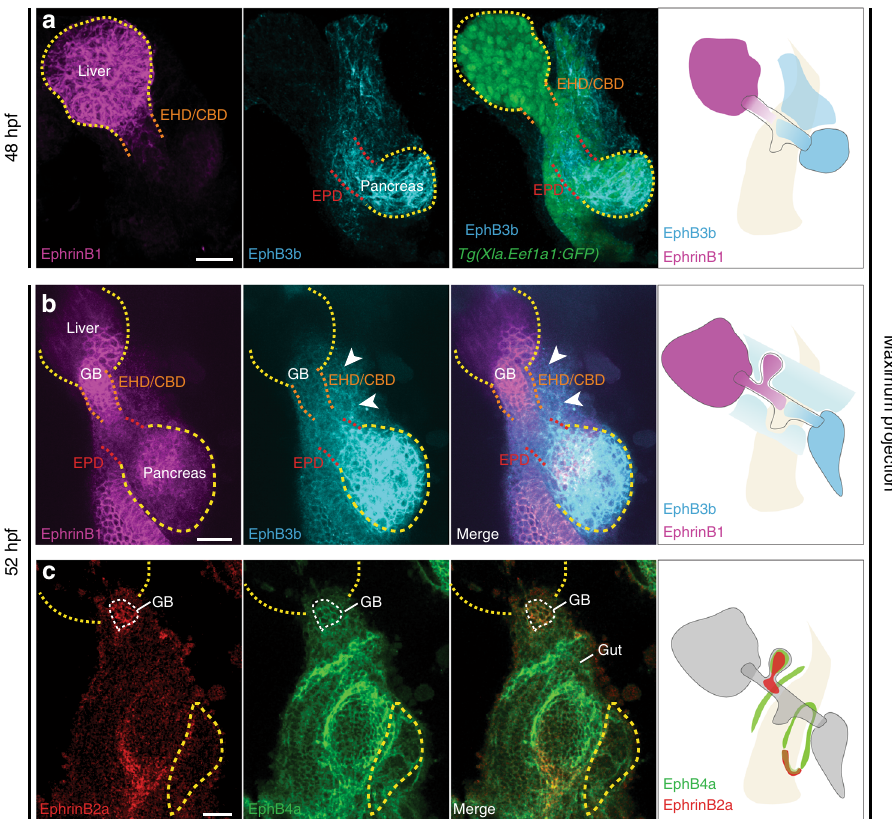
Fig. 6 Regionalized HPD endoderm and mesoderm expression of multiple EphrinBs and EphBs. a At 48 hpf, EphrinB1 is strongly expressed in the liver and at lower levels in the HPD primordium close to the liver. EphB3b expression is high in the pancreas and in the HPD primordium close to the pancreas and lower close to the liver, as well as very low in the HPD-adjacent mesoderm; pan-endodermal tg(Xla.Eef1a1:GFP) highlights the digestive system. b At 52 hpf, EphrinB1 is expressed in the liver (yellow dotted line) and EHB (white arrow), while EphB3b is highly expressed in the pancreas (yellow dotted line) and at low levels in the EPD (white arrow) and HPD mesenchyme (white arrowheads). c EphrinB2a and EphB4a are co-expressed in the gallbladder (white dashed line). EphrinB2a is present in the posterior region of the swim bladder. EphB4a is in the mesenchyme along the gut tube and around the swim bladder.